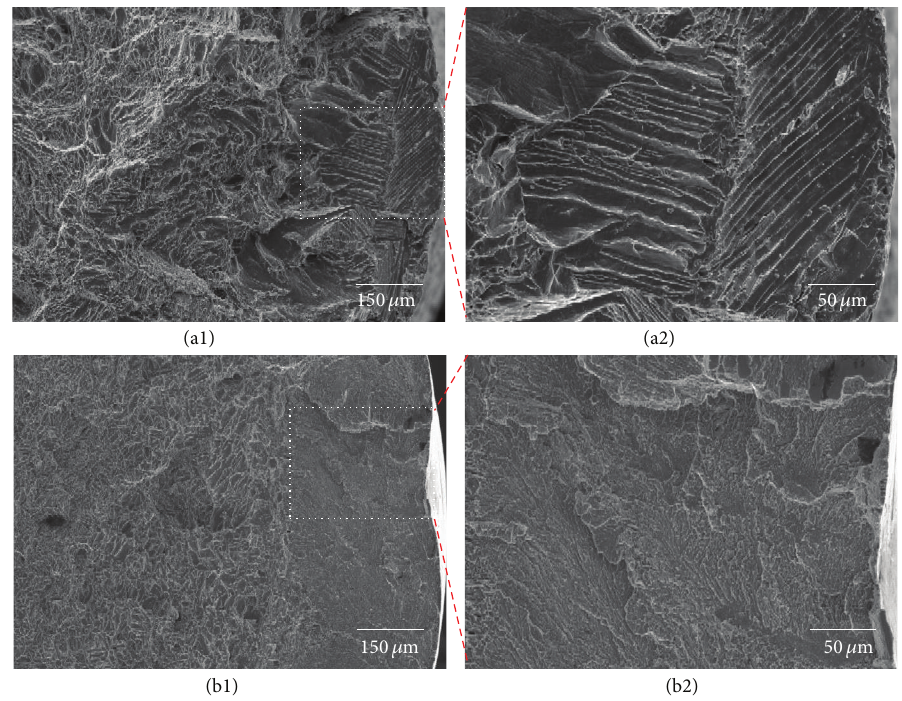
Figure 11: Fracture surfaces after tensile testing. (a1) Grade 2 control specimen and (a2) magnified image from dotted square (subsurface area) in (a1). (b1) Laser-treated grade 2 Ti specimen (current: 220 A, pulse: 10ms, and spot diameter: 1.0mm) and (b2) magnified image from dotted square (laser-treated area) in